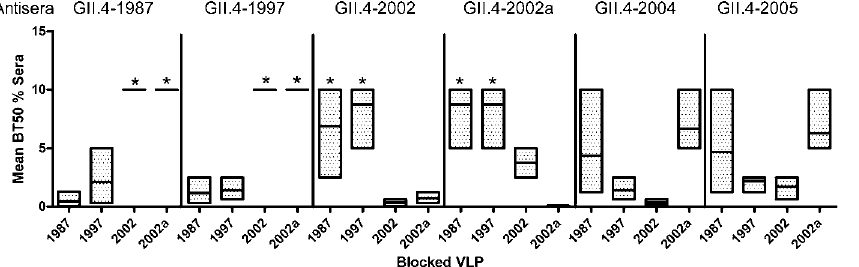
Figure 12. Murine Antisera Blockade of GII.4 VLP Binding to HBGAs Antisera collected from mice immunized against each GII.4 ORF2 were assayed for blockade of GII.4–1987- and GII.4–1997-H type 3, GII.4–2002a-Le a , and GII.4–2002-Le y interaction and the mean percentage of control binding calculated compared to the no-serum control. The floating bar plot shows the mean percentage of sera needed for BT50 for each antisera and each VLP; the mean titer is indicated by the line in the box. The upper and lower boundaries of the box represent the maximum and minimum values. Antisera groups that did not block 50% VLP–HBGA binding at the highest serum concentration tested (5%) were assigned an arbitrary value of 10%. *VLPs with significantly different BT50 titer compared to the homotypic antisera-VLP BT50 titer ( p , 0.05, one-way